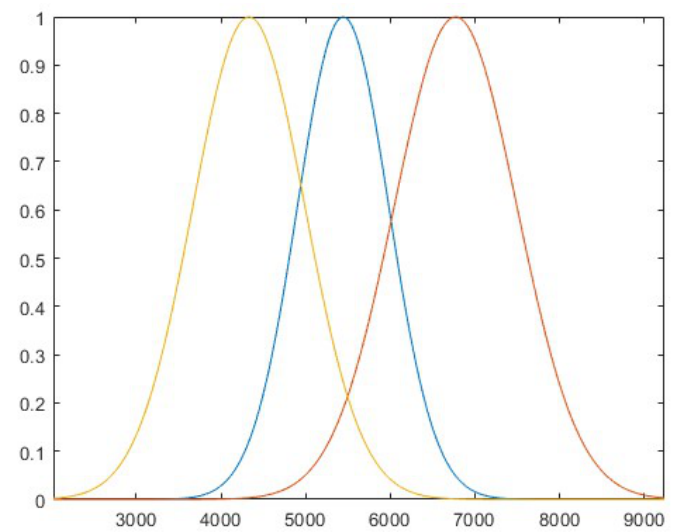
Figure 3. The Davies–Bouldin index.